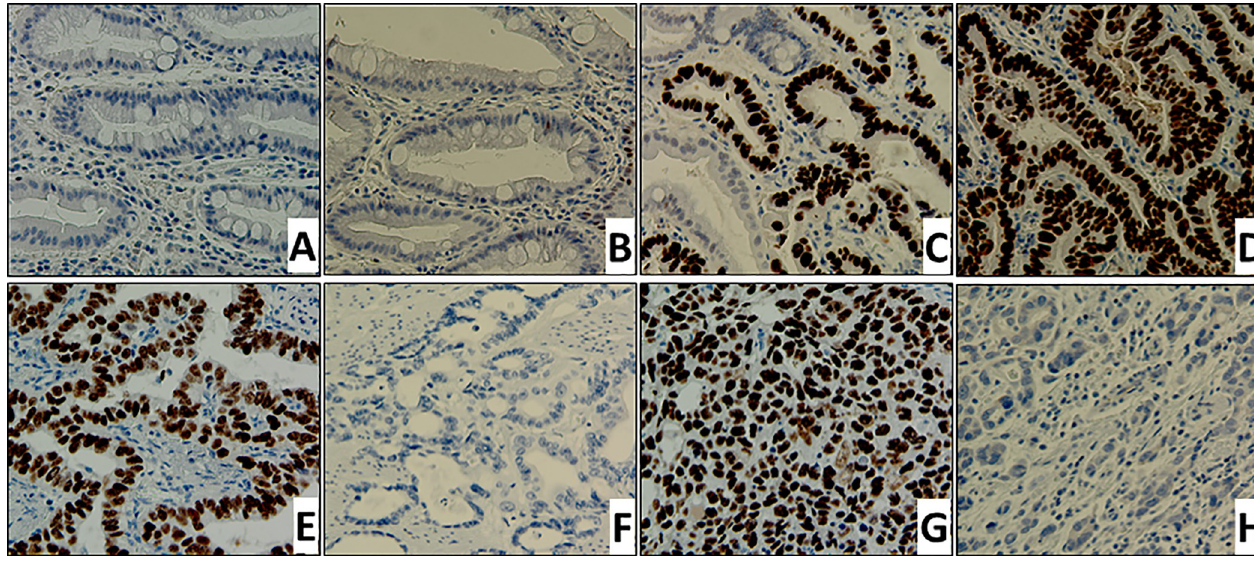
Fig 5. Differential patterns of TP53 IHC staining in ECA/GEJ Aca progression. Representative images of IHC staining (200x) of various GEJ lesions. A. and B. IM, C . LGD, D . HGD, WD-ECA/GEJ Aca to MD-ECA/GEJ Aca ( E and F ), and PD-ECA/GEJ Aca ( G and H ).